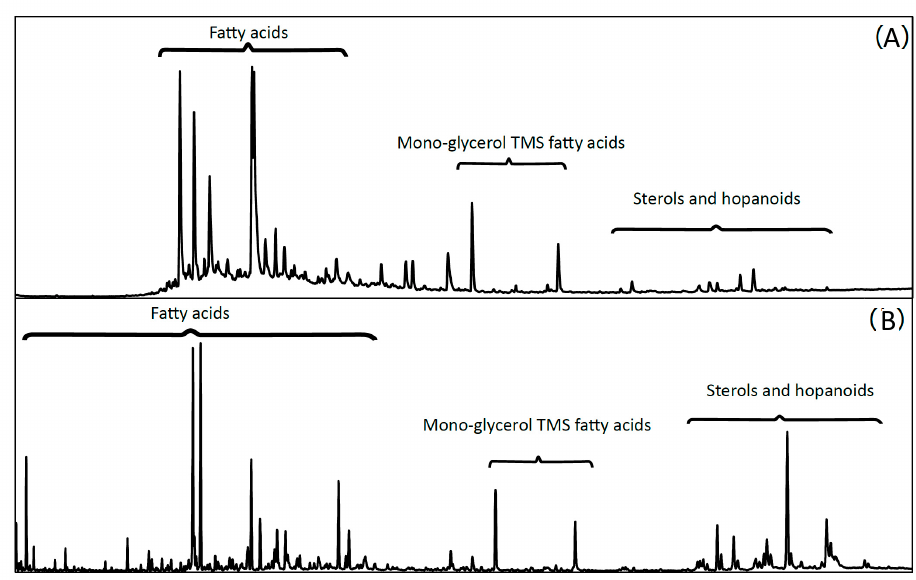
Figure 6. Gas chromatography mass spectrometry (GC / MS) chromatograms of lipid extracts showing major lipid classes identified in ( A ) Quaternary MnMISS samples. For comparison, ( B ) a modern active hydrothermal sediment from Spathi Bay, S. Milos [86].